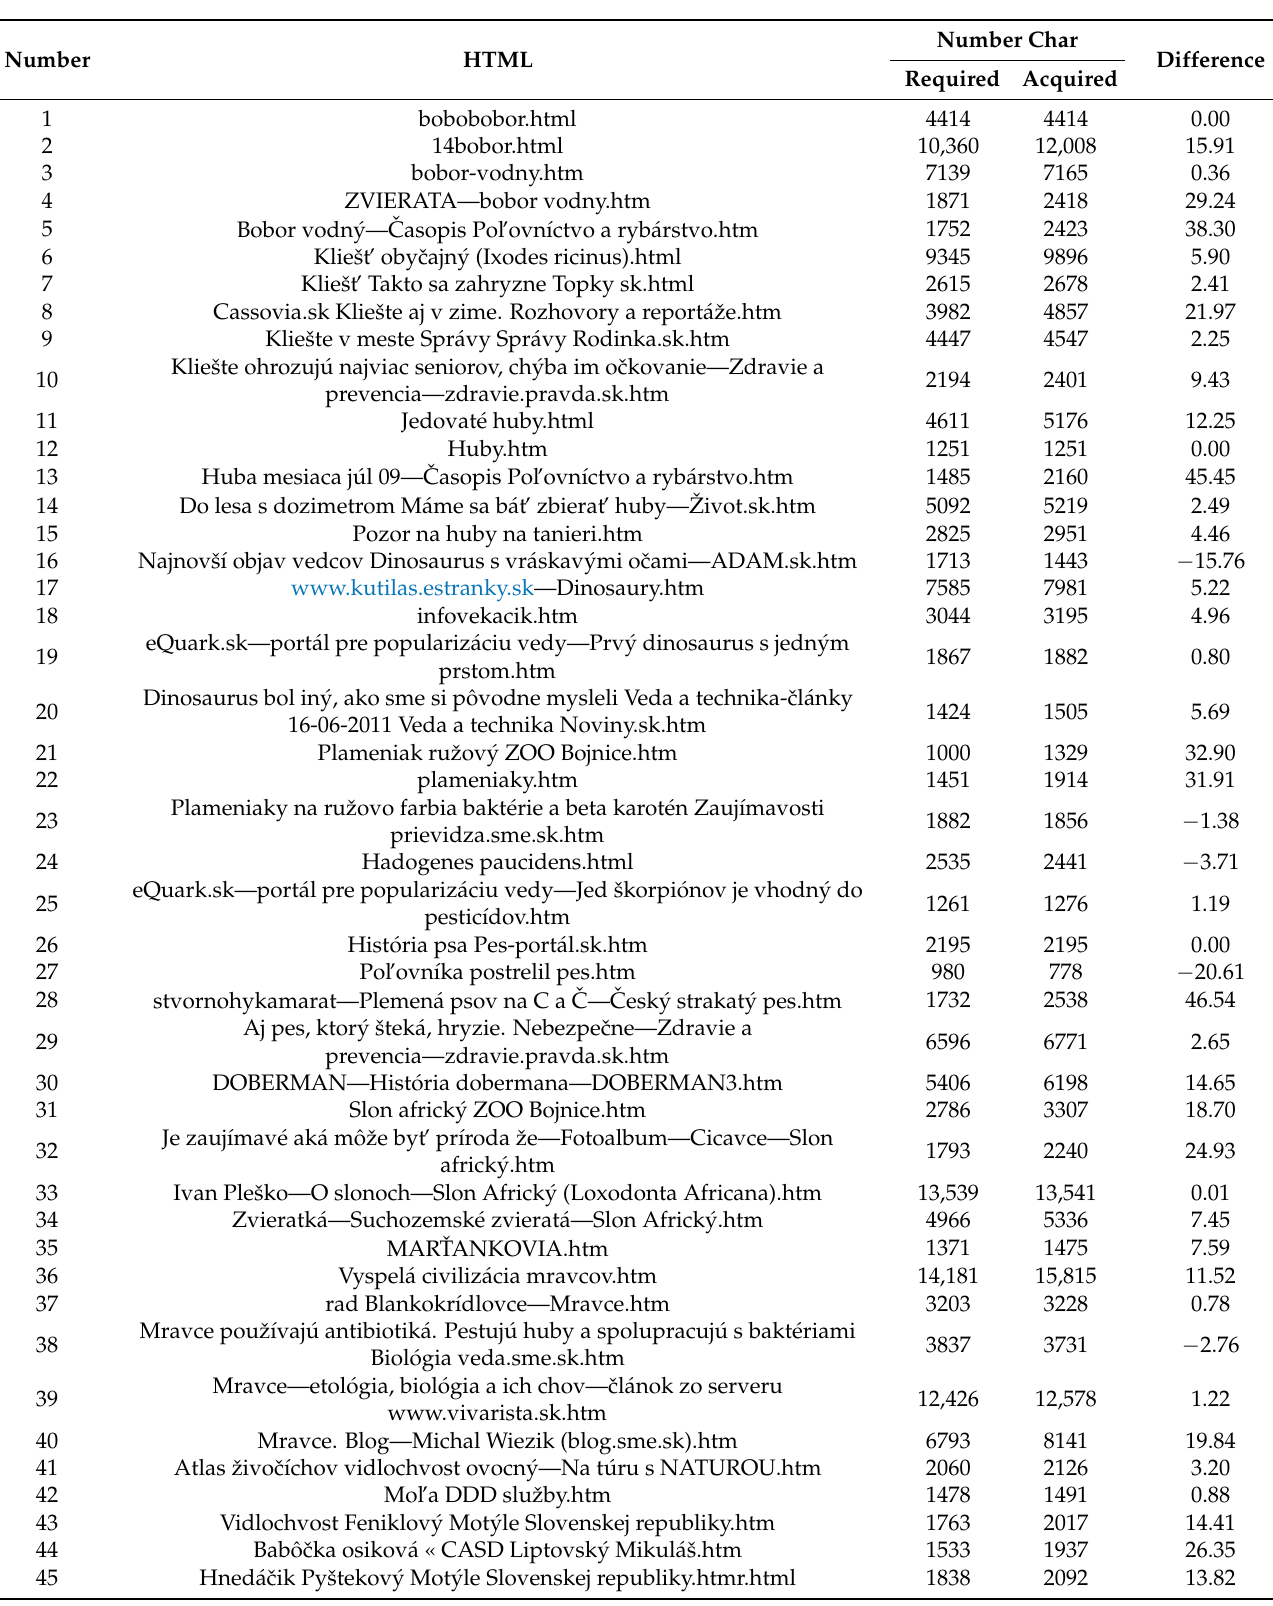
Table 1. The list of tested websites and extraction results (in Slovak